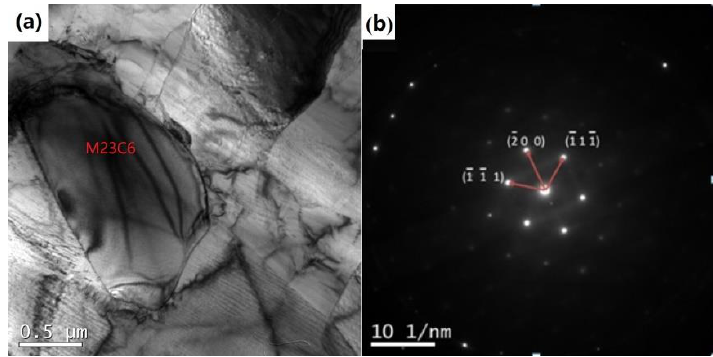
Figure 16. TEM micrograph of M 23 C 6 precipitates and their SAED. ( a ) bright field, ( b ) SAED.